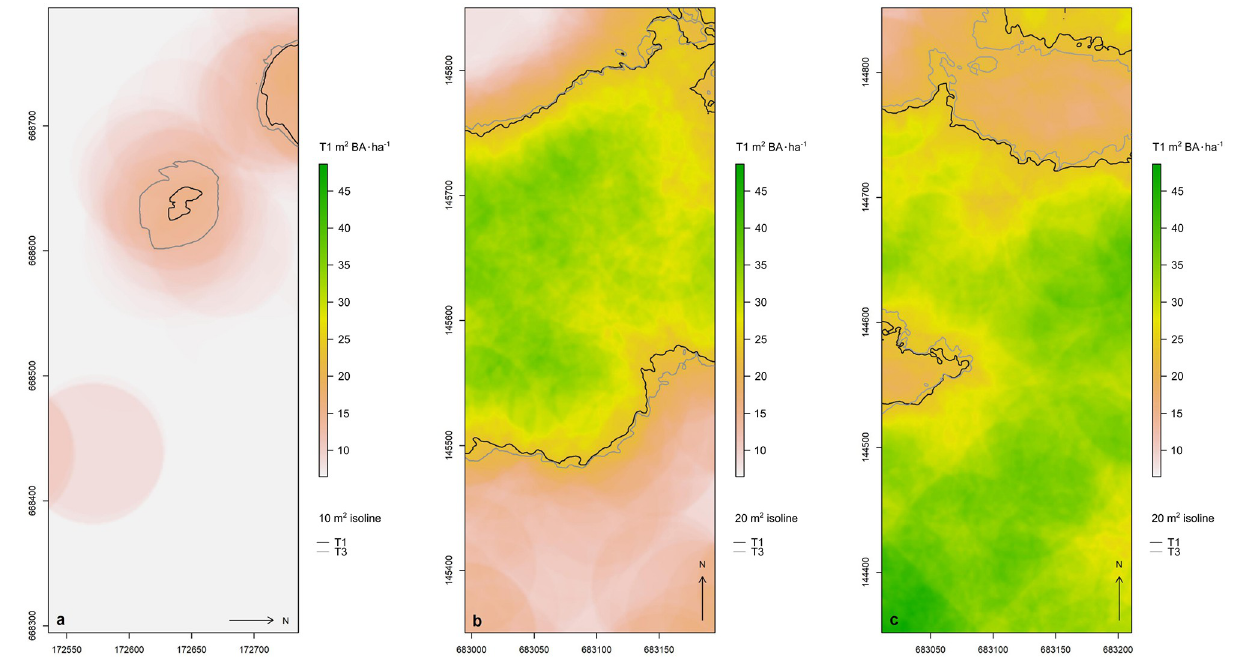
Fig 3. The movement of isolines of basal area intensity (m 2 BA ha − 1 ) across time. (a) edoro1 with 10 m 2 isoline, (b) lenda1 with 20 m 2 isoline, (c) lenda2 with 20 m 2 isoline. T1 = 1994/1995, T3 = 2007. All coordinates are in UTM 35N